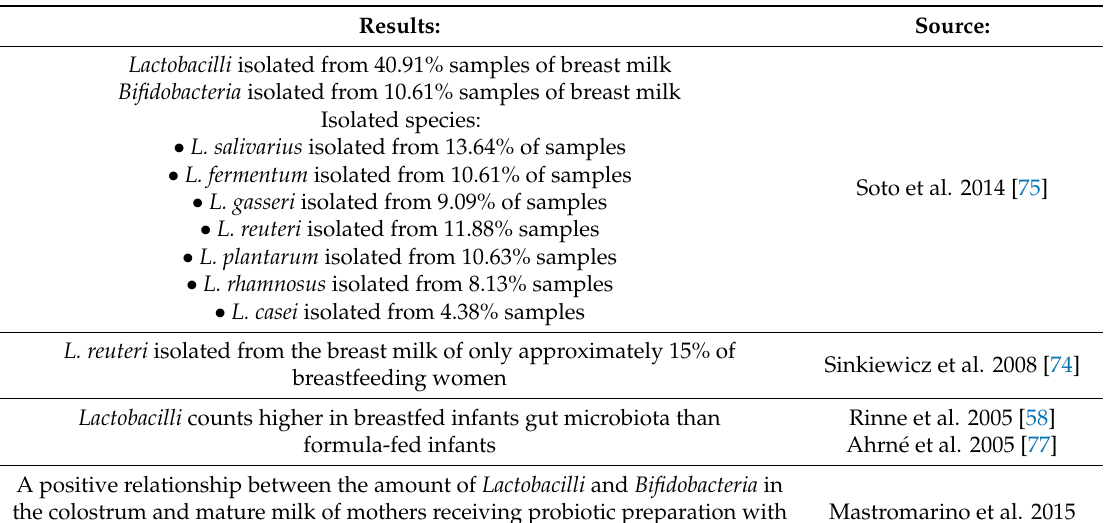
Table 1. Research on Lactobacillus in breast milk and important key results. Results: